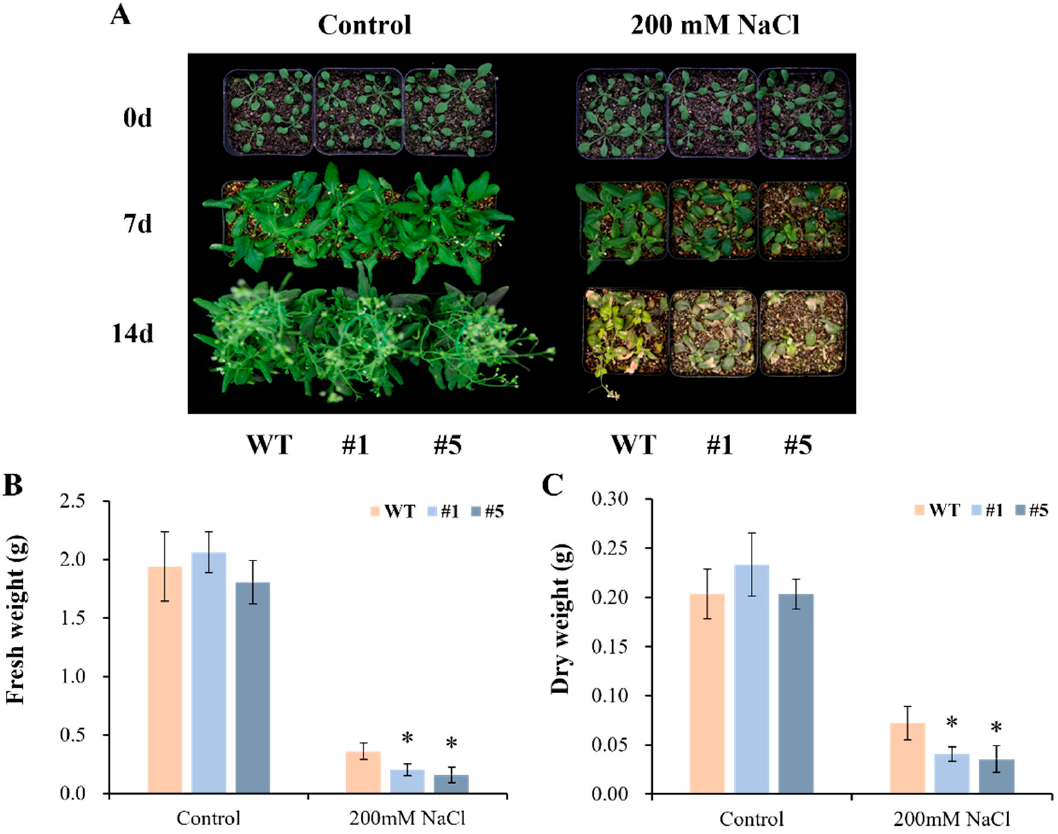
Figure 8. Overexpression CmHSP90.5 in Arabidopsis decreases survival rate under 200 mM NaCl treatment. ( A ) Phenotype of plants under salt stress and after 2-week recovery. ( B , C ) Fresh and dry weight measured after 2-week recovery. Error bars represent ± SE. * Statistically significant differ- ences were compared with Col-0 plants under different conditions. Value of p < 0.05 was considered to be statistically significant.